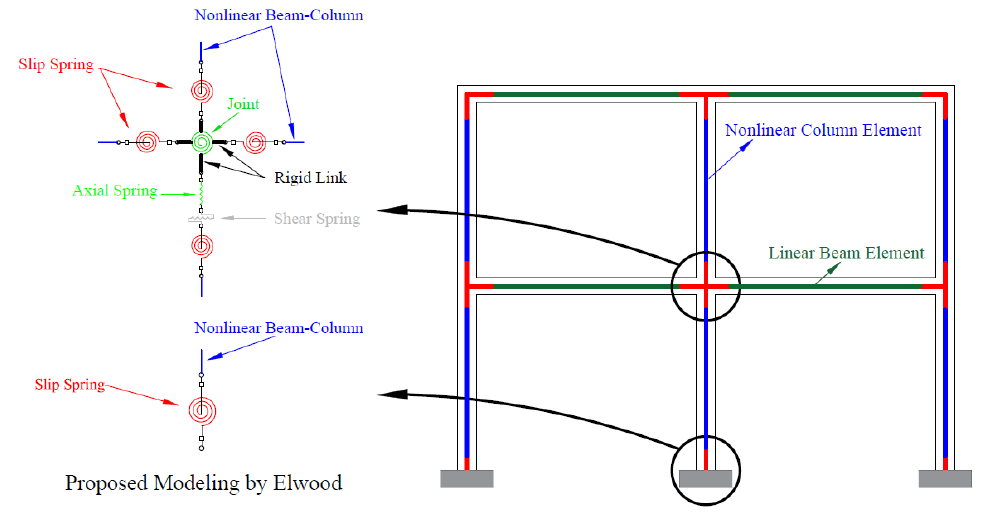
Fig. 2. Schematic presentation of the frame model.